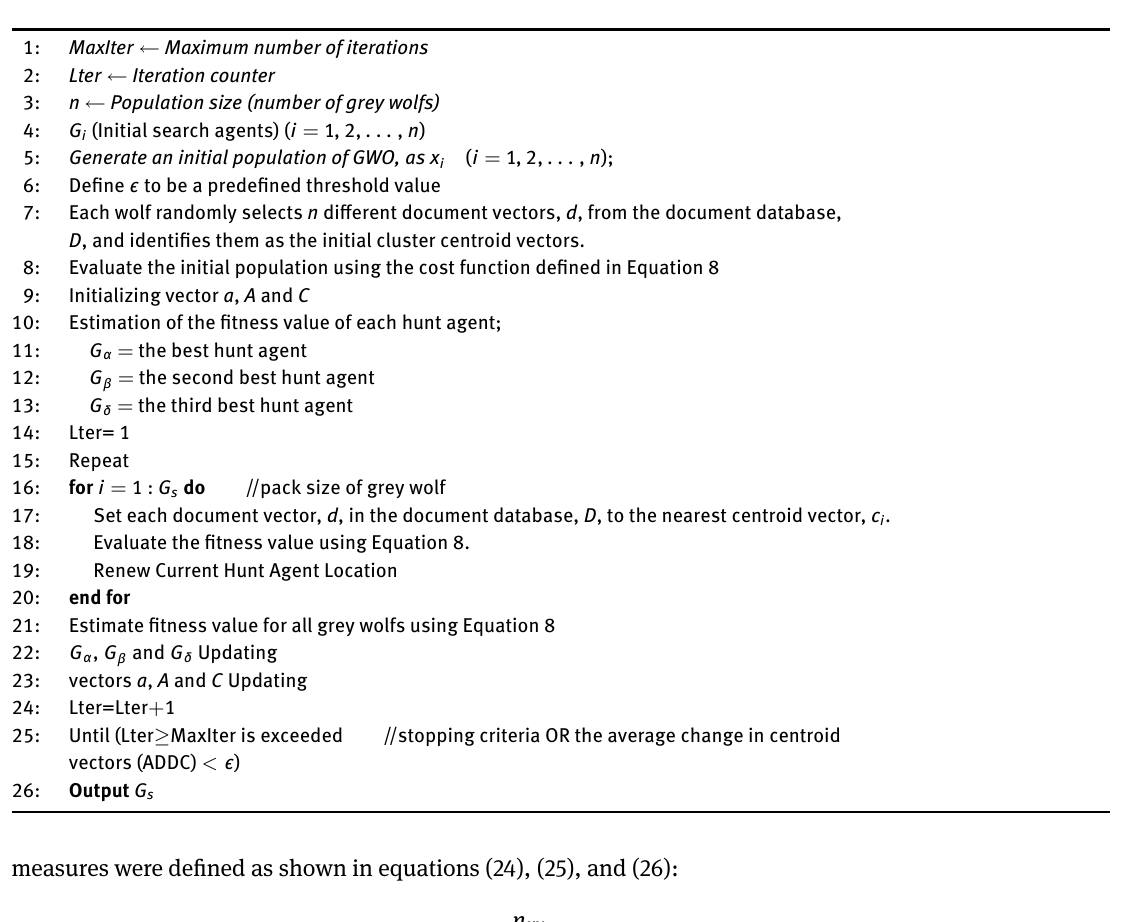
Algorithm 1: A Pseudo Code of Text Clustering Problem using